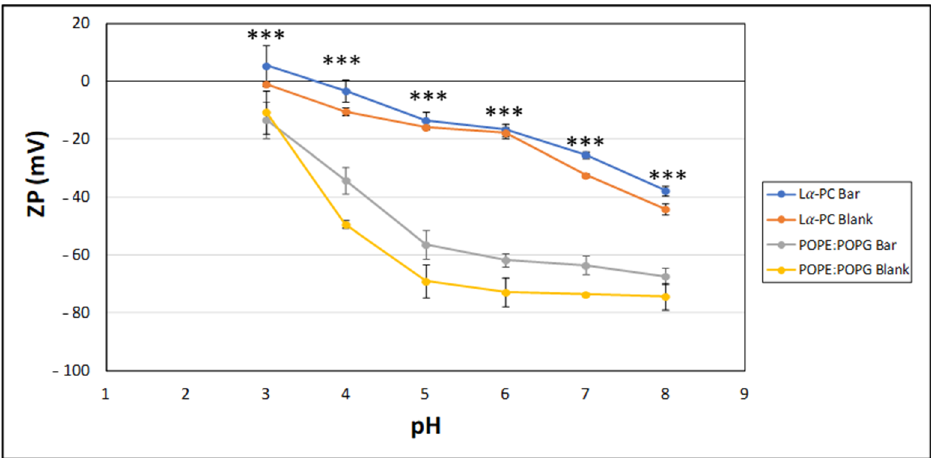
Figure 3. ZP of liposomes as a function of pH. Each point represents the Mean ± SD (n = 9). *** Statistical differences between L α -PC liposomes and POPE:POPG liposomes ( p < 0.0001) on a t -test analysis comparing L α -PC vs. POPE:POPG loaded with baricitinib. Significance level set at p < 0.05. L α -PC = L- α -phosphatidylcholine; POPE:POPG = 1-palmitoyl-2-oleoyl-phosphatidylethanolamine: 1-Palmitoyl-2-oleoyl-sn-glycerol-3-phosphoglycerol (3:1,